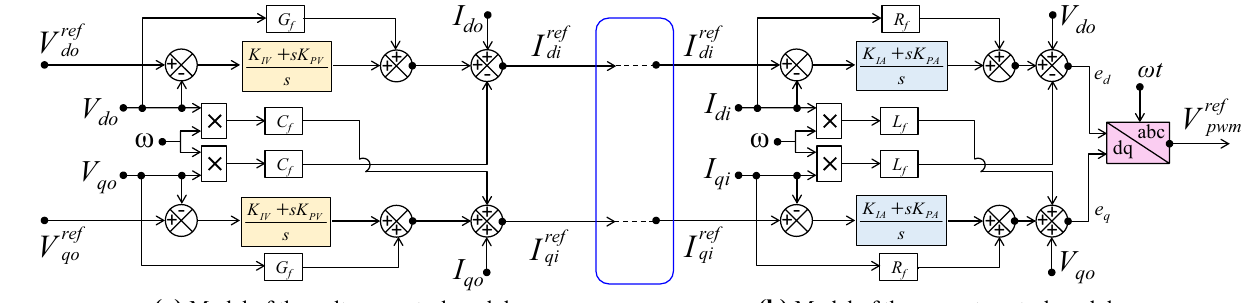
Fig. 2 Models of voltage and current (V/I) controllers used for RESM control